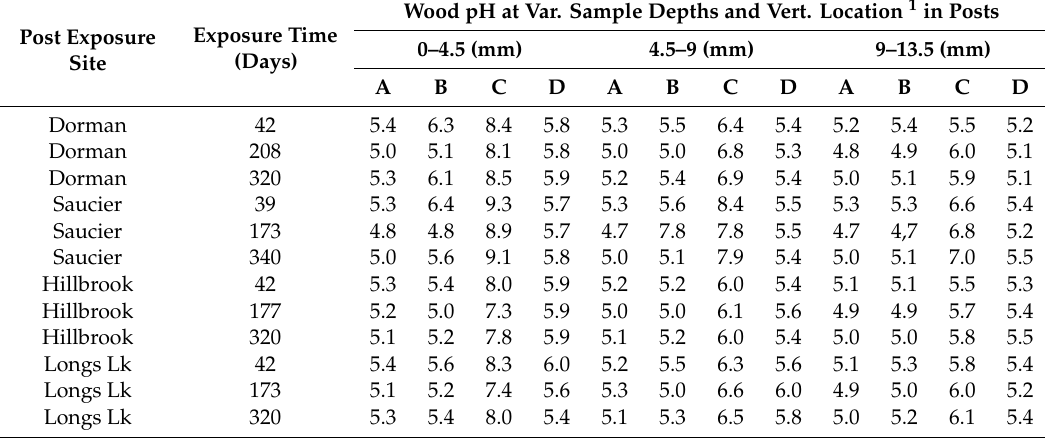
Table 1. E ff ect of cement on the pH of micronized or particulate copper azole system (MCA) treated wood after exposure of nominal 4 × 4 posts to soil contact at four di ff erent locations in